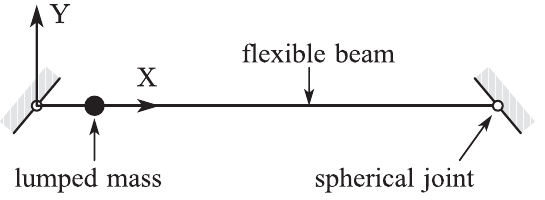
Figure 13. Initial configuration of numerical example